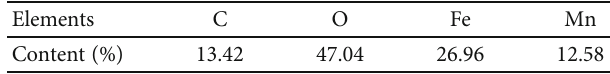
Table 1: The content of the element in Fe/Mn-C-LDH.